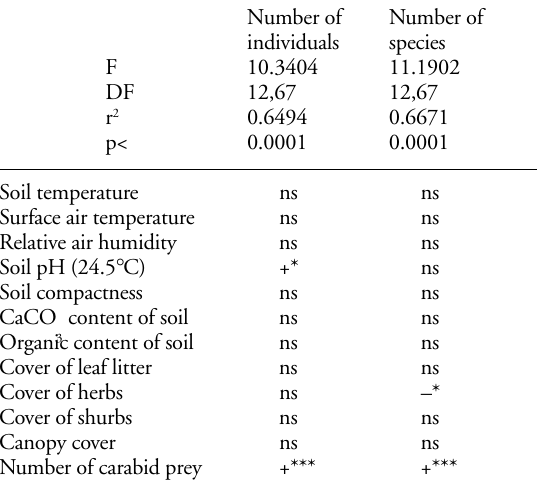
Table 2. Relationship between the number of individuals, the number of species per trap and the studied environmental variables by multiple linear regression. “ns” : not significant, * : p<0.05 and *** :